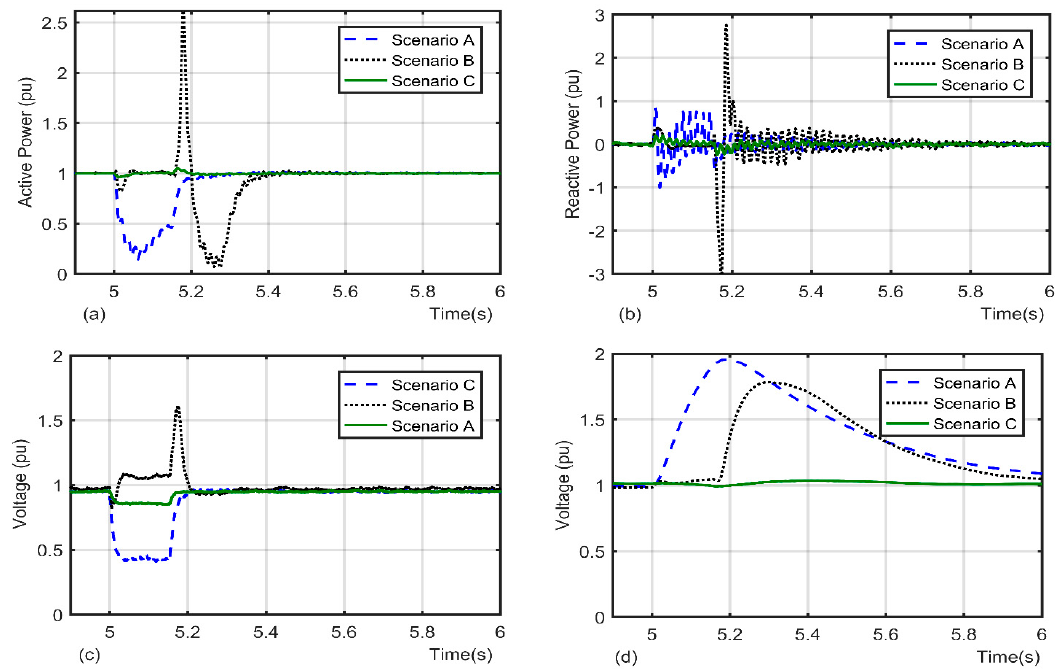
Figure 6. Medium voltage sag, ( a ) Active power, ( b ) Reactive power, ( c ) Terminal voltage, ( d ) DC link voltage.